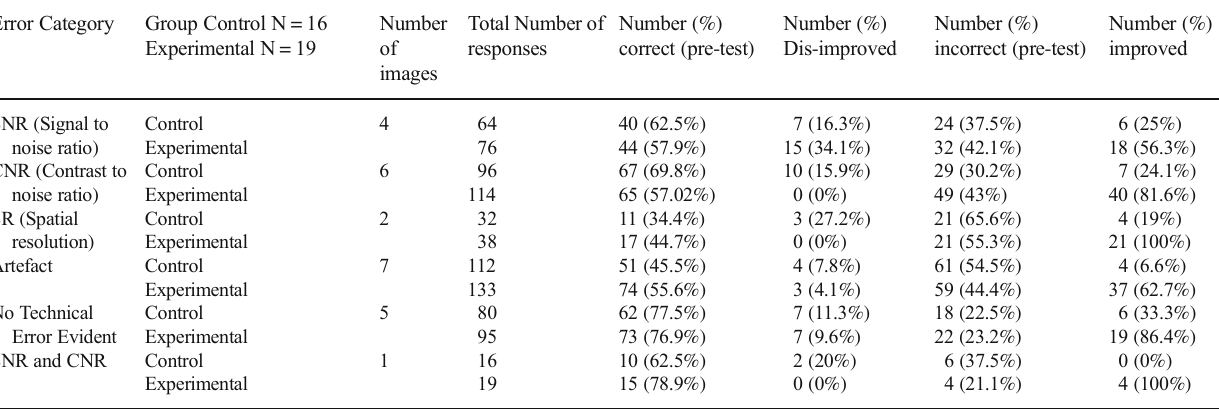
Variations in radiographer responses in identifying different types of MR image-quality errors Error